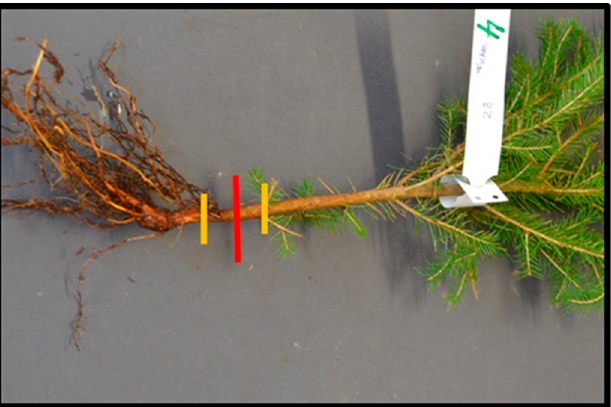
Figure 2. Pre-experiment detection of Heterobasidion species from Norway spruce saplings. The disks from spruce trunk were cut 3.5 cm above and 3.5 cm underneath the root neck, which is shown in the figure as a red line. The topmost 1 cm and the lowermost 1 cm of the trunk were stored in the refrigerator for pre-incubation.